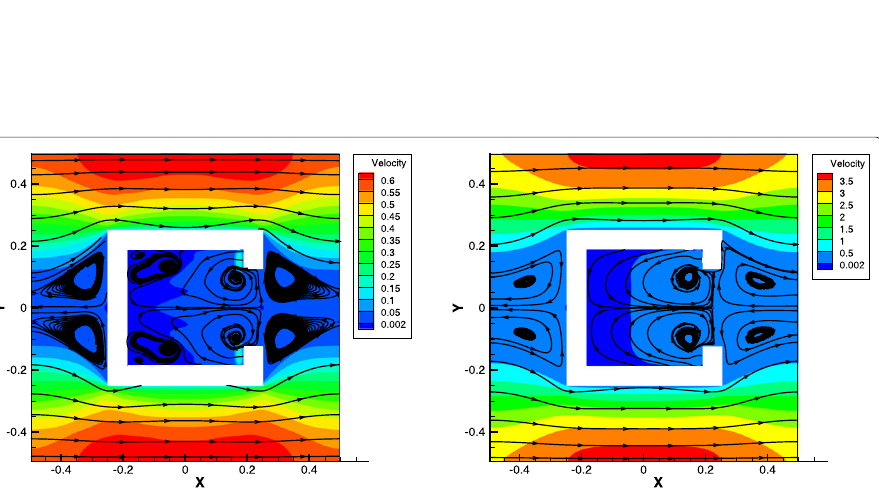
Fig. 10 The streamline and velocity magnitude of the micro flow through periodic square cylinders. Left figure shows the solution with Knudsen number Kn = 1.0 × 10 − 1 , and right figure shows the solution with Knudsen number Kn = 1.0 × 10 −